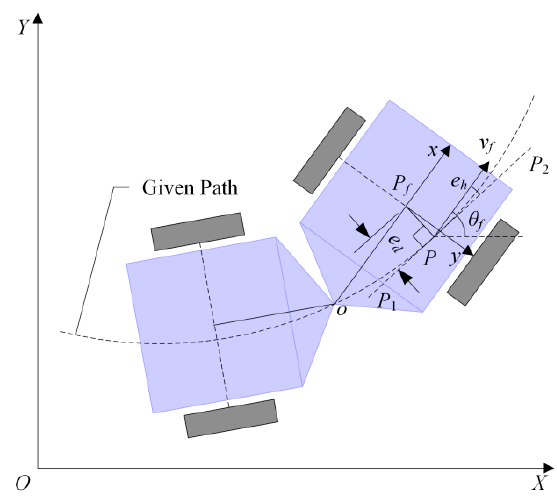
Figure 3. Displacement error and heading error.